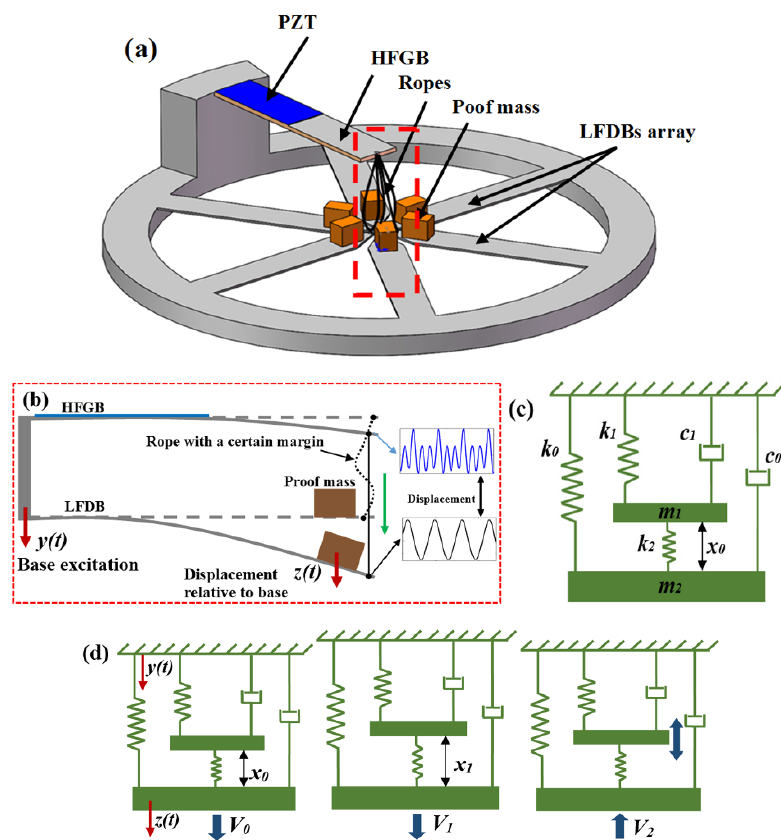
Figure 1. ( a ) Architecture of the novel wideband vibration energy harvester (VEH), ( b ) architecture, ( c ) schematic model, and ( d ) operation mechanism of the individual low-frequency driving beam (LFDB) driving a high-frequency generating beam (HFGB) VEH system.